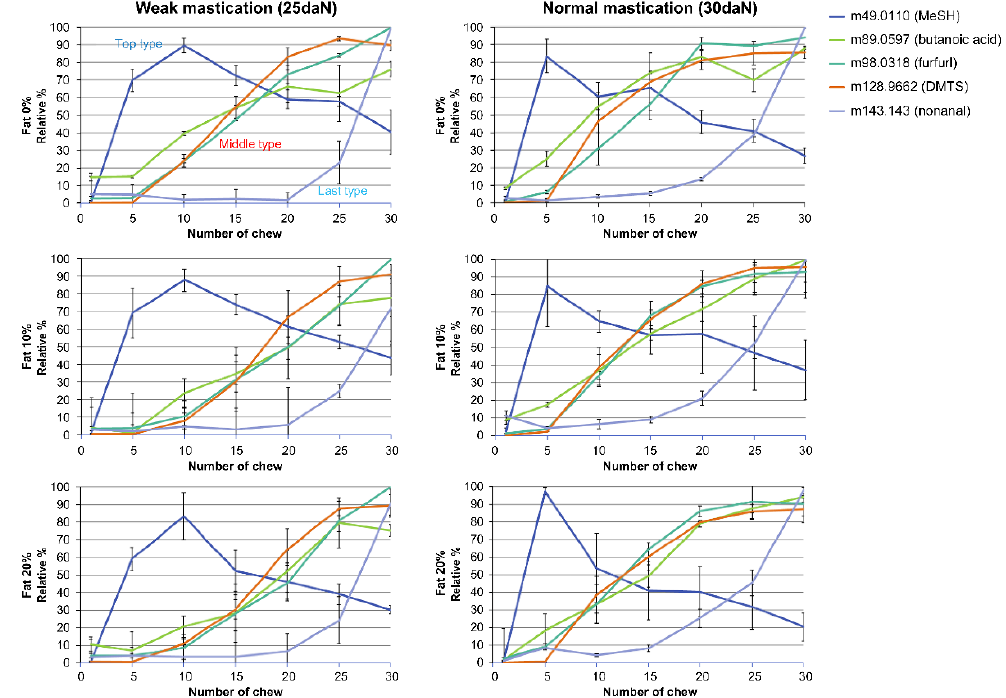
Figure 2. Changes in the release of aroma compounds caused by differences in mastication strengths and amounts (%) of fat (release curve). The number of chews means the number of cycles of chewing simulator jaw.